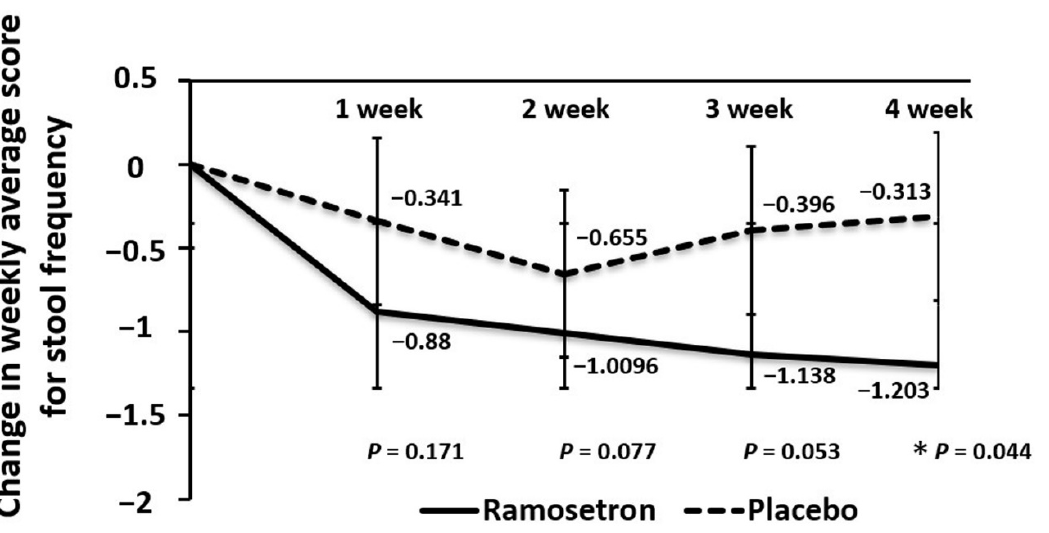
Figure 6. Weekly changes in stool frequency. Results are expressed as mean ± SD. * p < 0.05 vs. placebo.